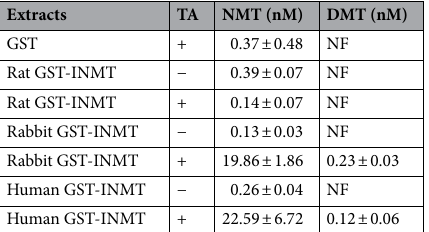
Table 2. uHPLC-MS/MS confirmation of enzymatic activity of recombinant rat, rabbit, and human INMTs. Values shown are averages of triplicates for each condition ± standard deviation. TA = tryptamine, NF = peak not